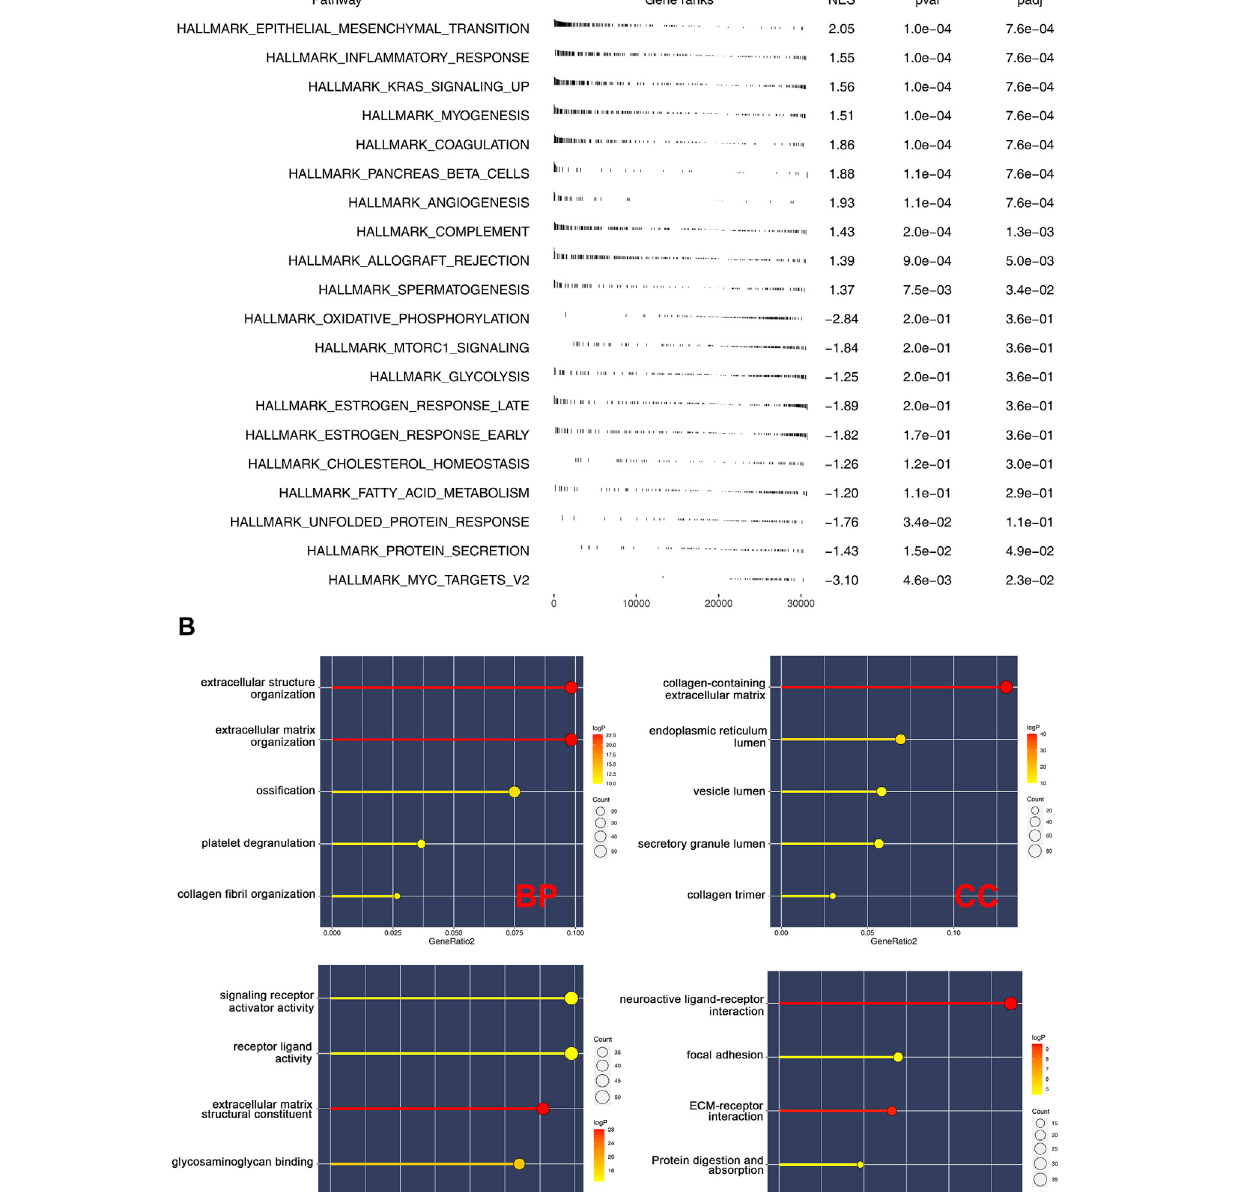
Frontiers in Genetics |